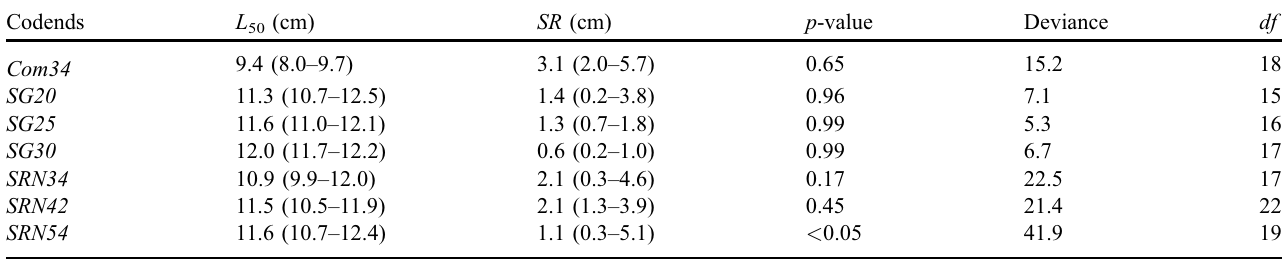
Table 4. Selectivity parameters and fi t statistics for P. leptodactylus in the experiments (analysed based on the selected model. SR : selection range; df : degrees of freedom. The values in parentheses are the Efron ’ s (1982) 95% CIs .